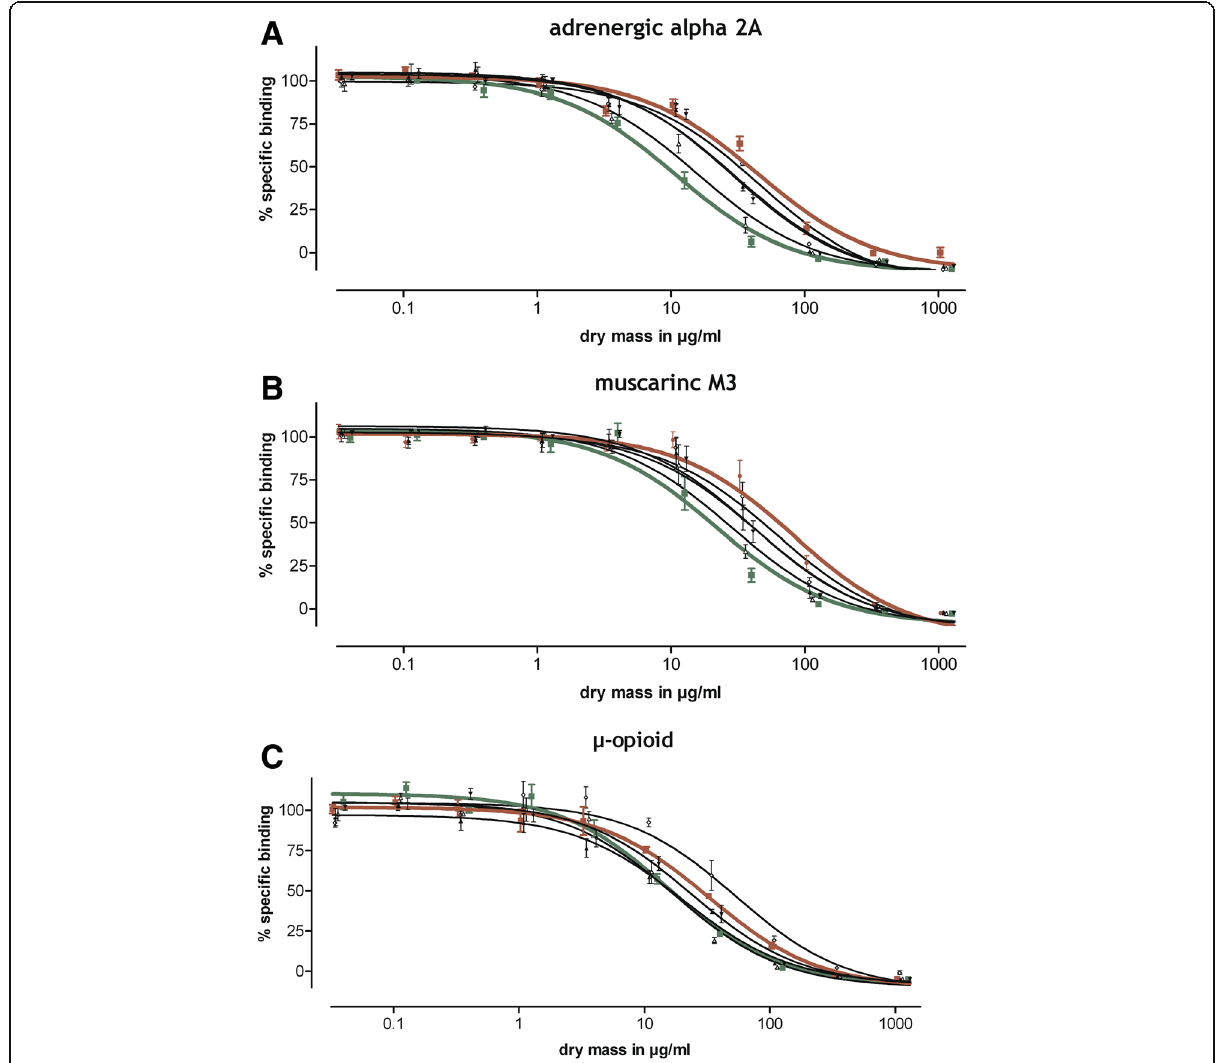
Fig. 2 Influence of the manufacturing process. Competition binding of different ethanolic Salvia officinalis extracts (highlighted: green of fresh leaves, brown of dry stipes) at the human adrenergic alpha 2A receptor expressed in Chem-1 cells ( a ), the muscarinic M3 receptor expressed in CHO cells ( b ), and the human μ -opioid receptor expressed in CHO-K1 cells ( c ). Summary curves over 2 independent experiments performed in duplicate (mean specific binding ± S.E.M.)